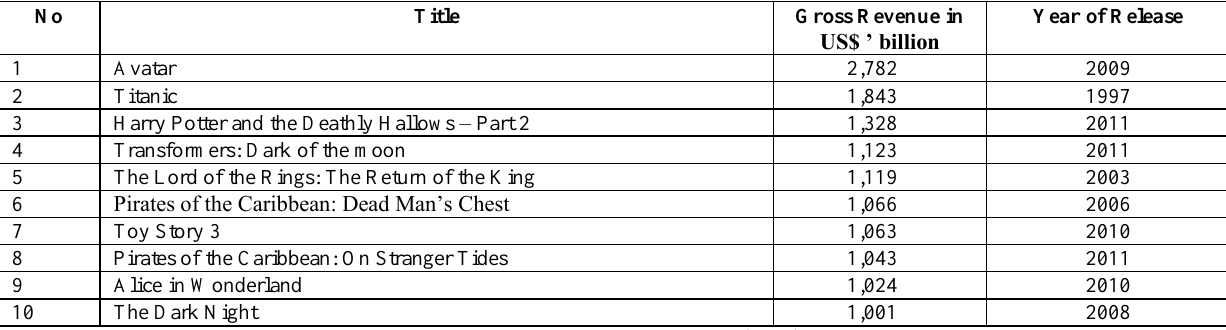
Table 1: Highest grossing films released